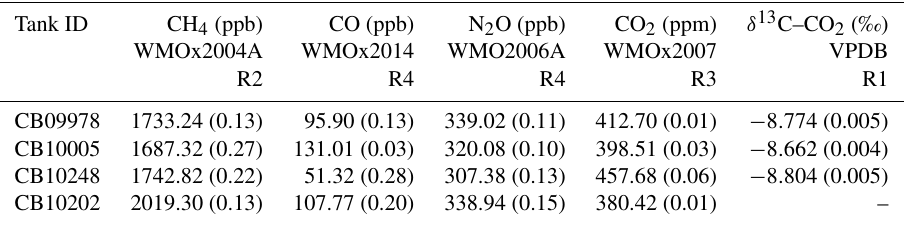
Table C1. Aniwaniwa suite composition with assignment uncertainty bracketed (1 σ ). δ 13 C–CO 2 was not assigned at NOAA ESRL GMD, but measured at NIWA-Gaslab. The current WMO reference scales are given along with the spectral analysis region that retrievals are performed